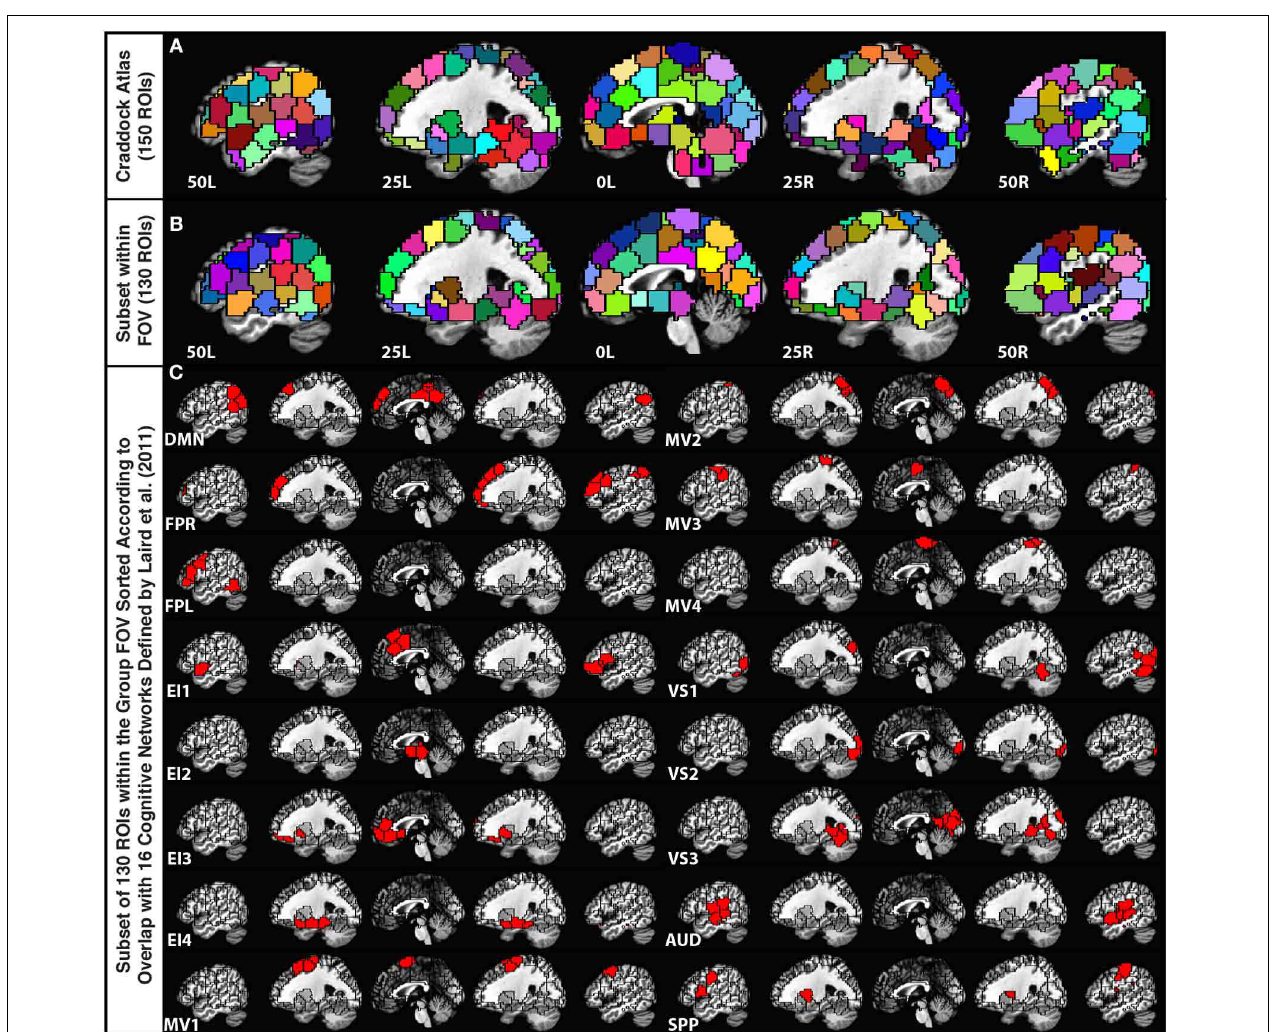
FIGURE 1 | (A) Depiction of the 150-ROI Craddock Atlas on top of five sagittal slices in the MNI stereotaxic space. (B) Depiction of the remaining 130 ROIs from the atlas considered in this study. ROIs eliminated from the original atlas